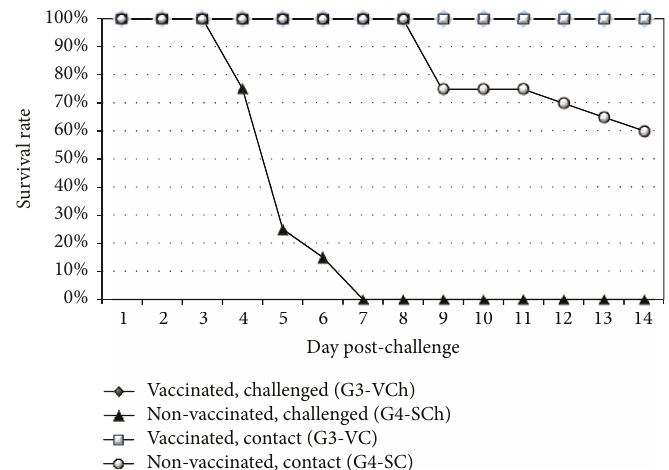
Figure 5: Time course of mortality in challenged layers. Contact challenged groups were comingled with direct-challenged groups from 8 hours postchallenge. Sampling date refers to the time after direct